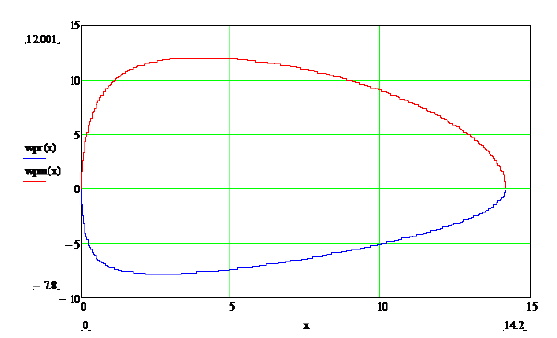
Figure 6. The variation of the piston speed lus of the kinematic parameters: the average speed of the piston during the compression stroke w mr =5,8 m/s, the movement time during the compression stoke τ pr =0,024 s, the average speed during the useful stroke w mm =9,3 m/s, the movement time in the useful stroke τ pm =0,015 s, the average speed during one engine cycle w m =7,2 m/s, the movement time during one engine cycle τ pm =0,04 s, the frequency of the engine cycle f p =25,2 Hz. The piston speed variation is presented in Figure 6.